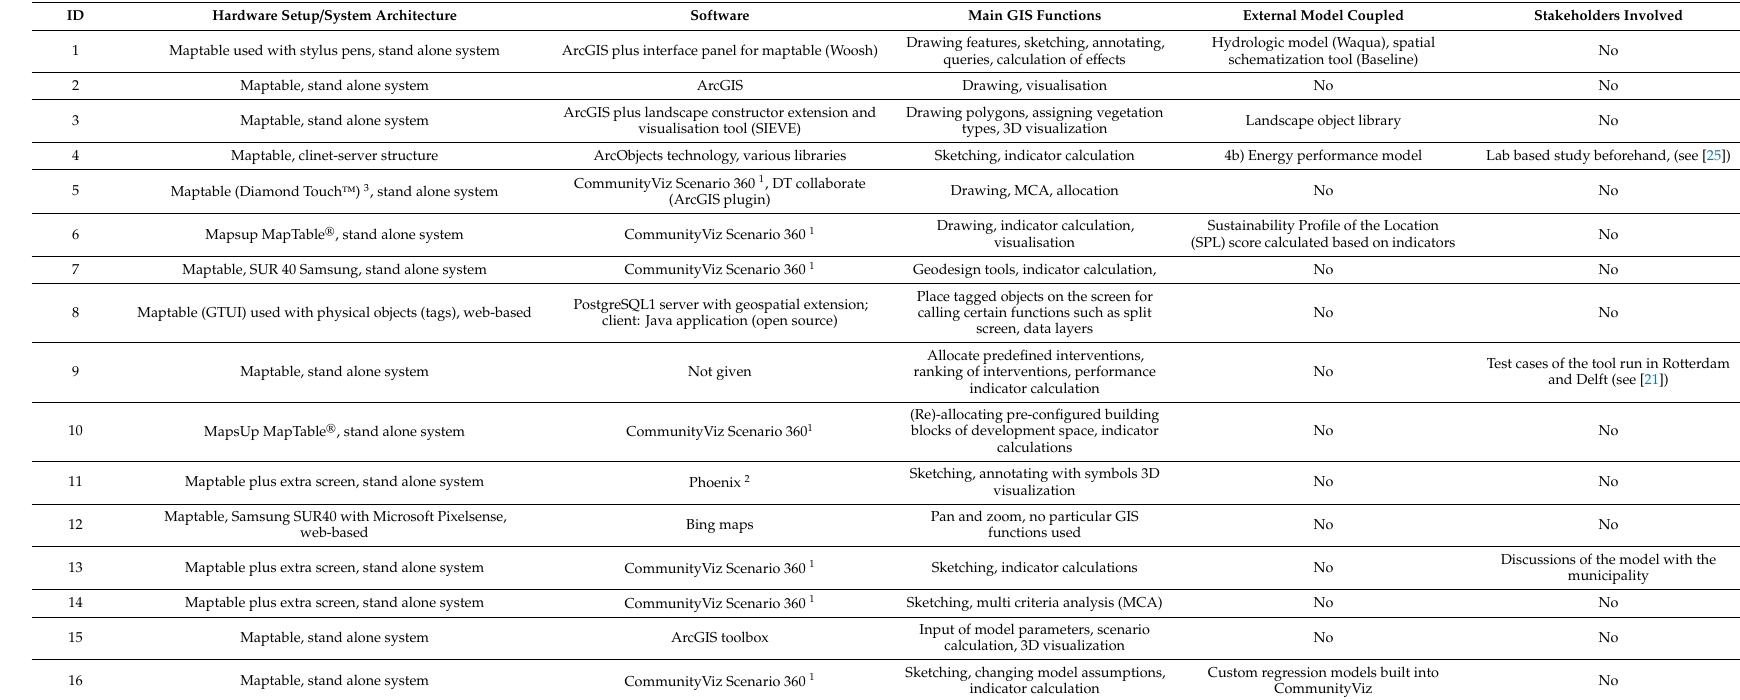
Table A2. Interactive PSS